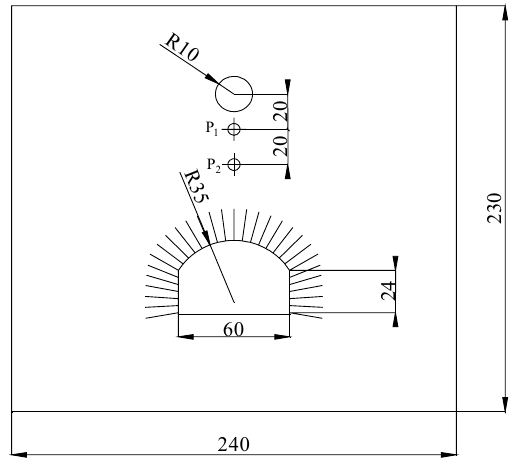
Figure 3. Schematic representation of the numerical model (unit: